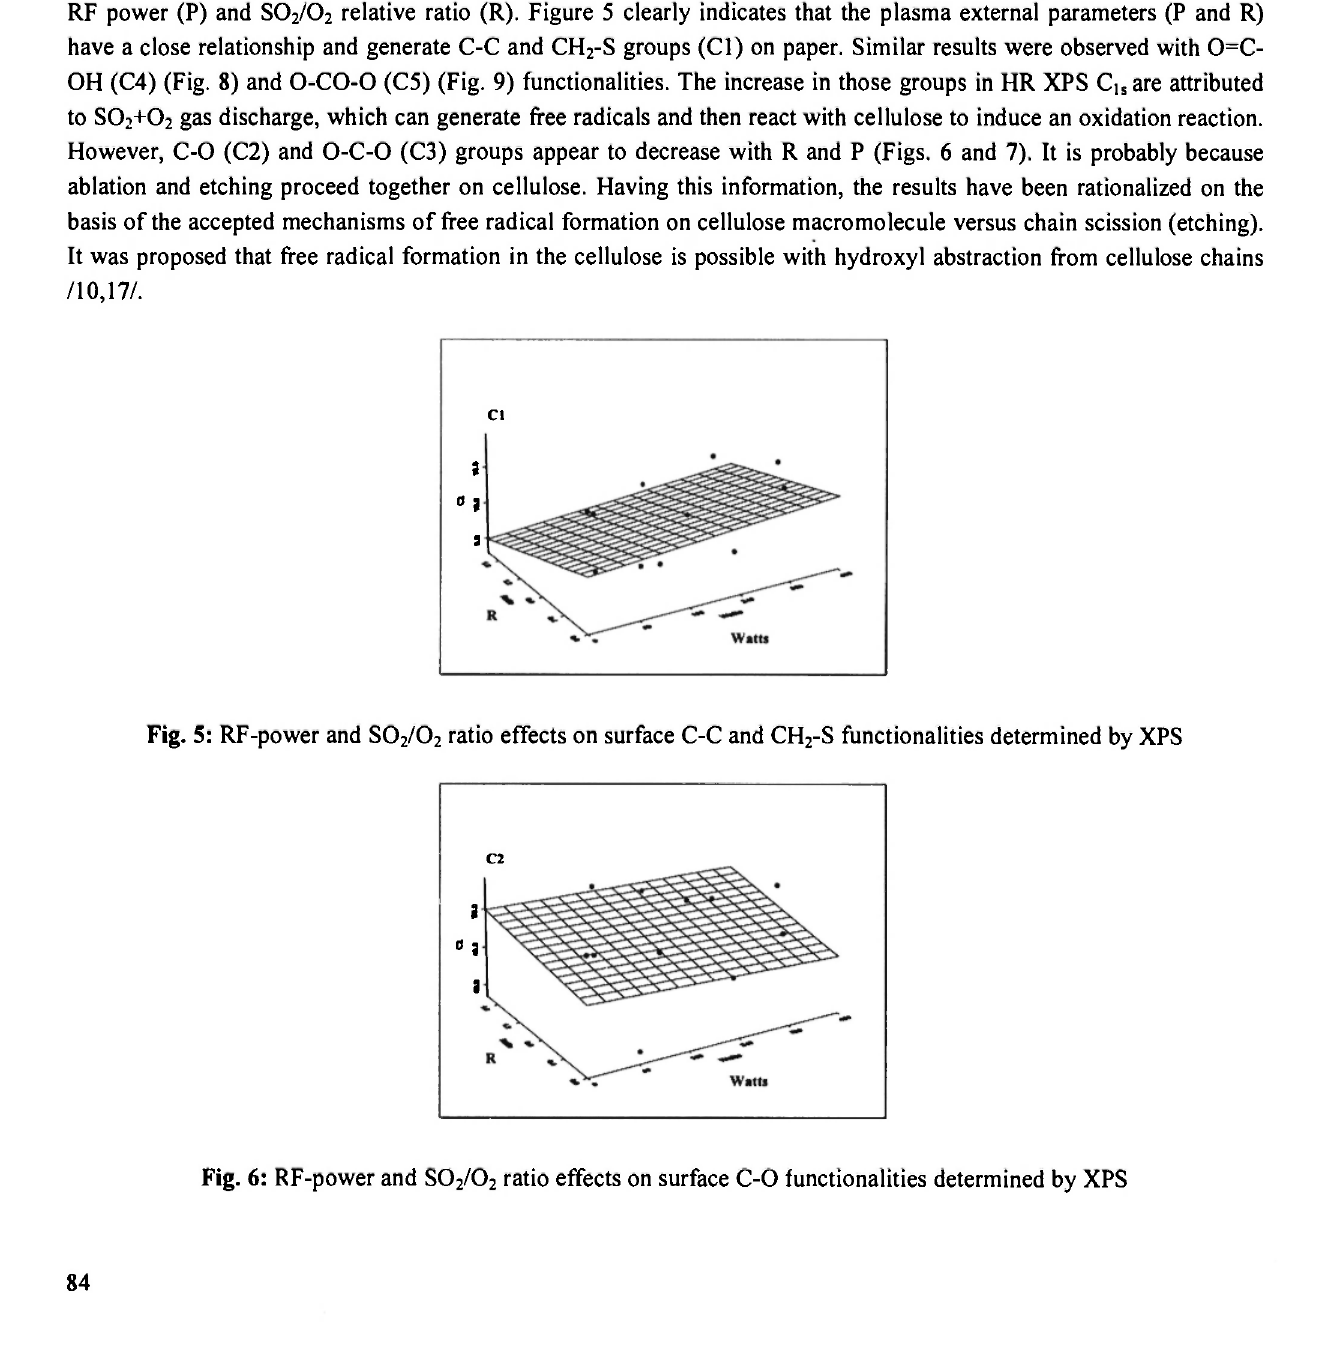
Fig. 5: RF-power and S0 2 /0 2 ratio effects on surface C-C and CH 2 -S functionalities determined by XPS